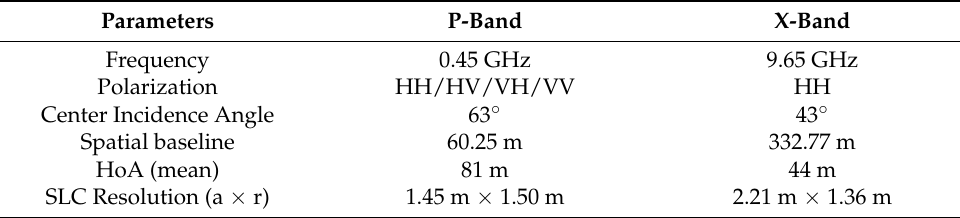
Table 2. Parameters of acquired P-band and X-band InSAR data *.